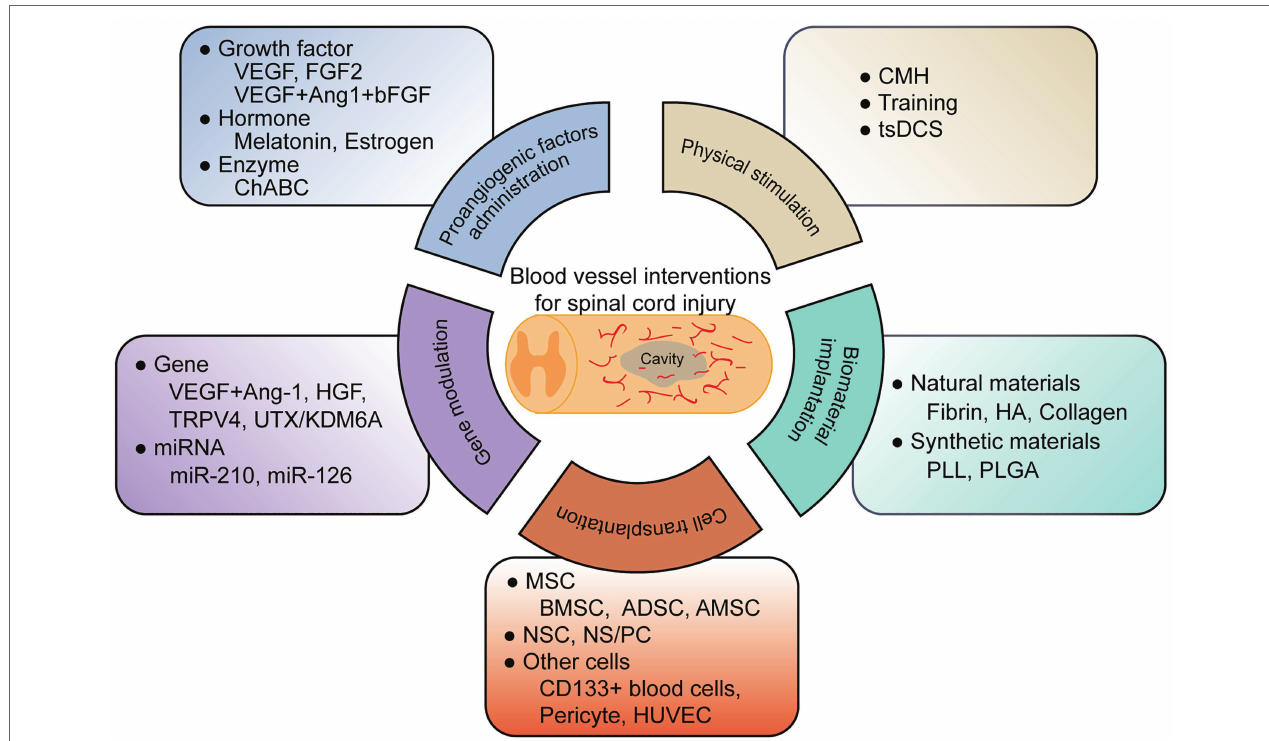
FIGURE 1 | A graphic summary of current blood vessel interventions for spinal cord